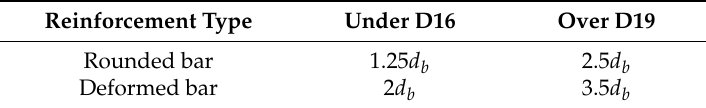
Table 3. Minimum inner radius of reinforcement bending (Code